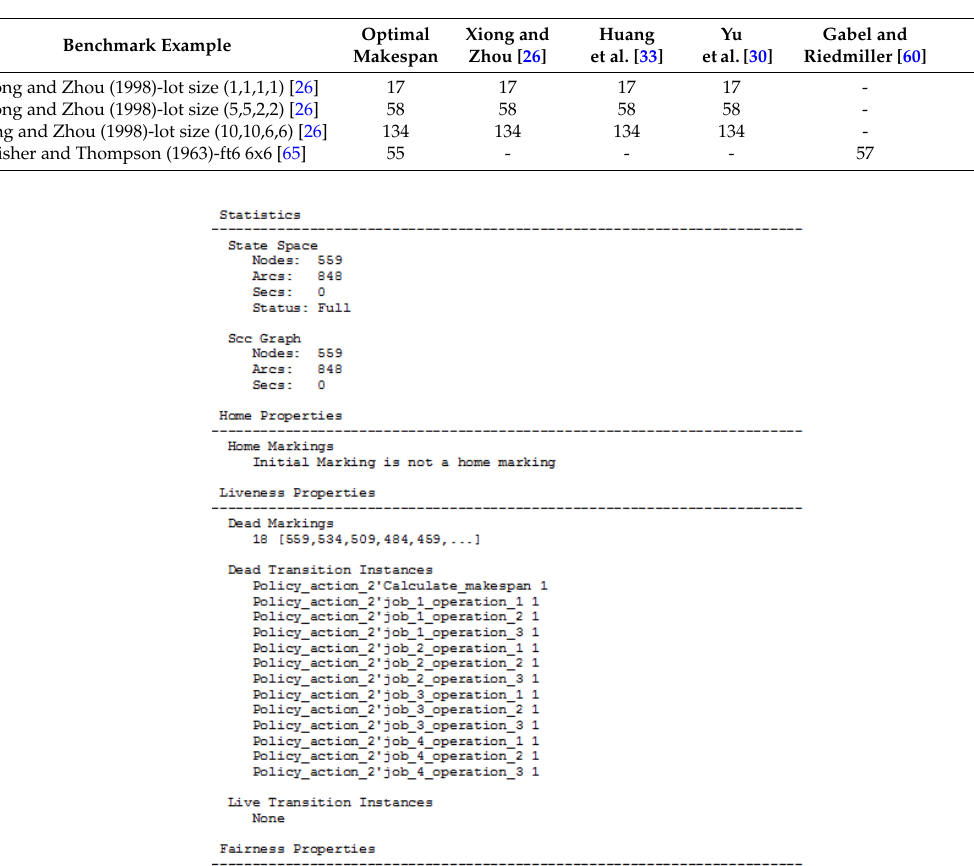
Table 4. Simulation comparison results for the makespan of job shop benchmark examples. The number in parentheses corresponds to the percentage of the scheduling agent Q-learning visits to the best obtained solution in 1000 cycles, i.e., in one simulation experiment.